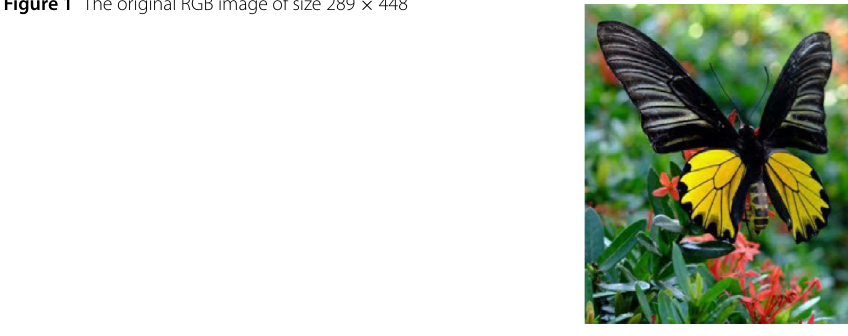
Figure 1 The original RGB image of size 289 ×